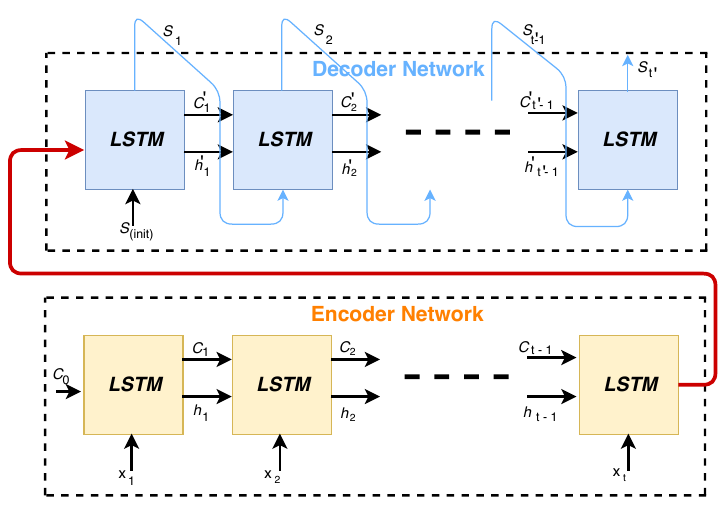
Figure 1. LSTM encoder–decoder